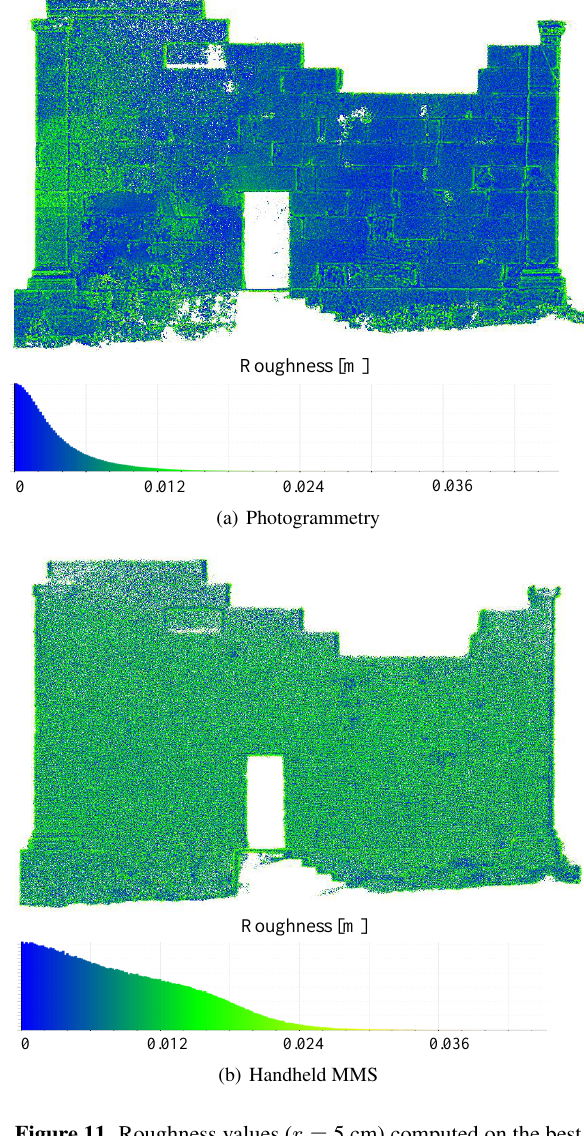
Figure 11. Roughness values ( r = 5 cm) computed on the best preserved wall of the temple for the photogrammetric model (a) and the handheld MMS point cloud